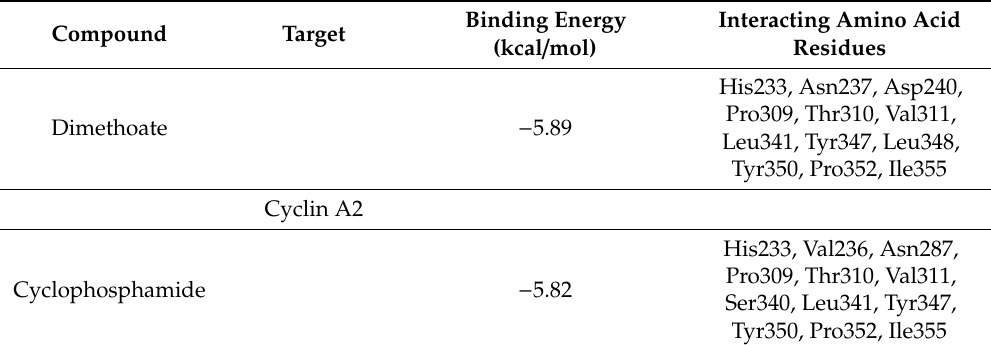
Figure 6. Molecular docking showed strong hydrophobic interaction and hydrogen bonding in “CPA- Cyclin A2” interactions ( a ) Interaction of cyclophosphamide with cyclin A2. The ligand (Cyclophosphamide) has been shown in “stick” representation. ( b ) “Ligplot” of Figure 6a showing bonding interactions.